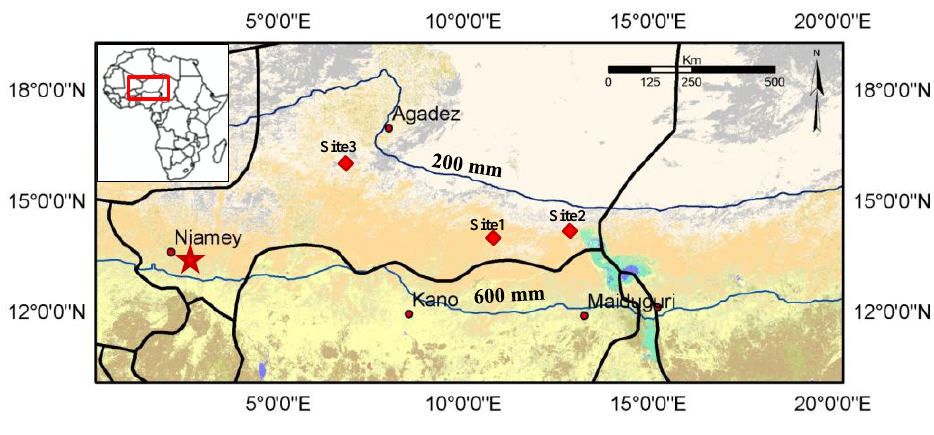
Figure 1. The study area overlaid on the regional GlobCover (GC) map of Africa [51]; the red star shows the position of the eddy covariance station; the red diamonds represent the field sites; the blue lines indicate the isohyet boundaries of 200–600